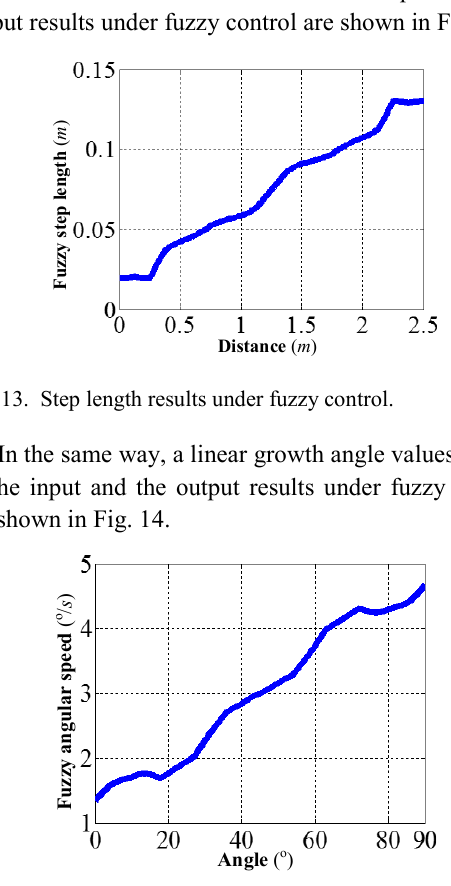
Fig. 14. Angular speed results under fuzzy control.